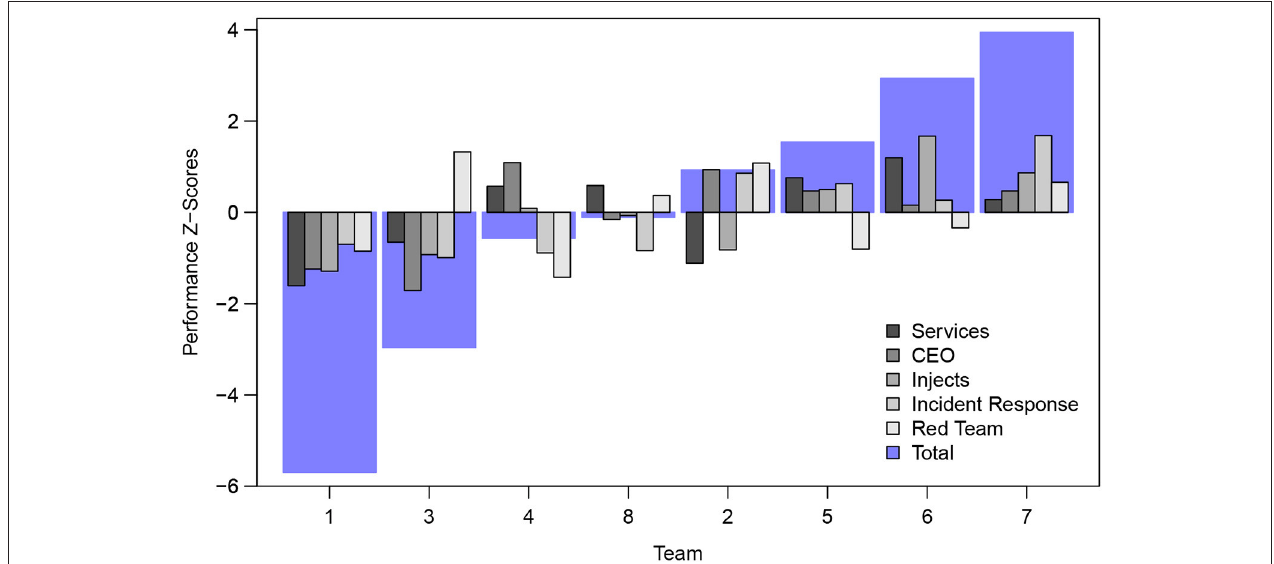
FIGURE 4 | The composite overall team score in the MACCDC 2017 competition was composed of five performance metrics. These included: (1) Maintaining Services, (2) CEO Reporting, (3) Scenario Injects, (4) Incident Response, and (5) Red Team Activity. Performance scores are normalized z-scores and the teams arrayed with increasing composite performance by team